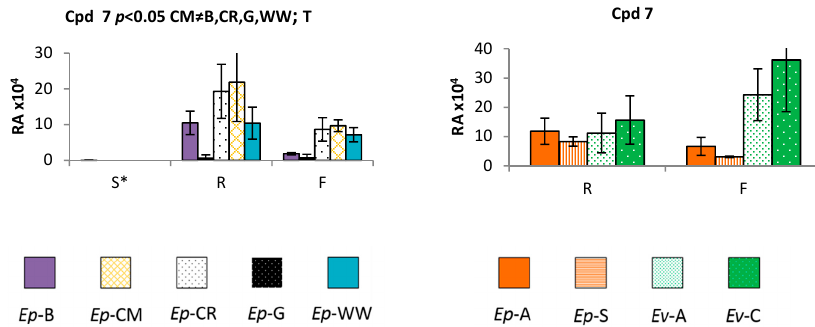
Figure 4. Relative abundance (RA) of 1 , 2 and 7 based on the peak area and averaged over replication in Echium plantagineum ( Ep ) and E. vulgare ( Ev ) in glasshouse controlled conditions. Error bars represent standard error of the mean (SEM). Key: ( a ) Ep -B-Bendigo, Ep -CM-Coombah, Ep -CR-Cobar, Ep -G-Grenfell, Ep -WW-Wagga Wagga; ( b ) Ep -A–Adelong, Ep -S-Silverton, Ev -A–Adaminaby, Ev-C–Cooma. Significant differences ( p < 0.05): (cid:54) = —between populations, Sp—between species and T—between time points. Int—significant interaction, time × population. S—seedling,